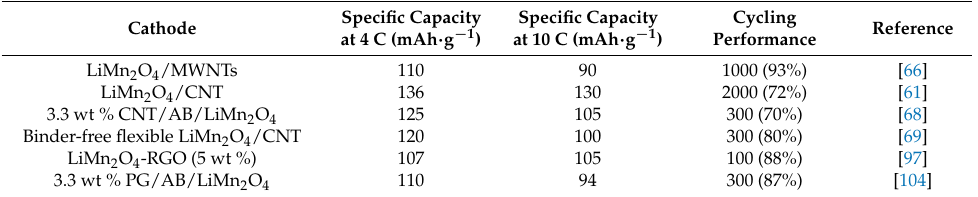
Table 2. Comparison of different conductive additives in LiMn 2 O 4 cathodes in aqueous batteries.